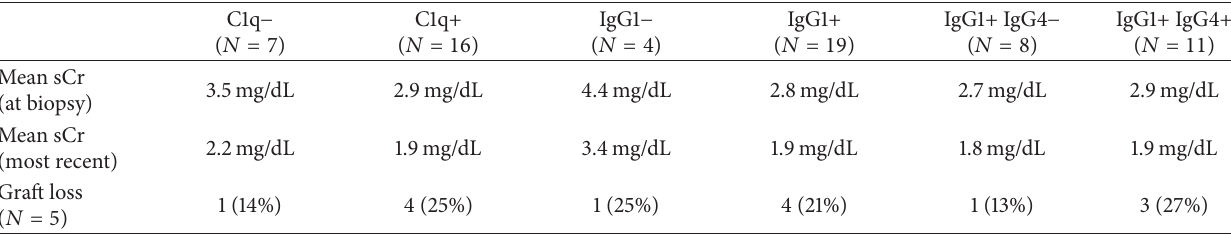
Table 9: Analysis of C1q, IgG subclass, and Cd4d+ DSA.